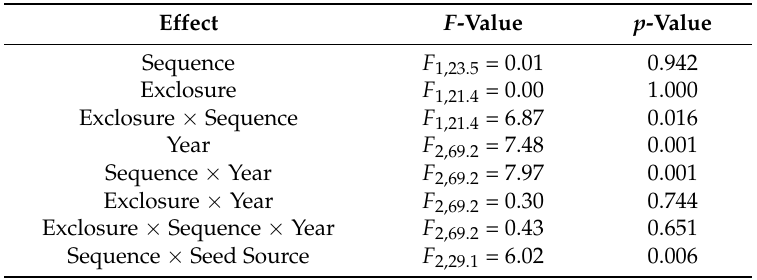
Table 1. Final generalized linear mixed model for established birch seedling densities. See Methods section for model specification.